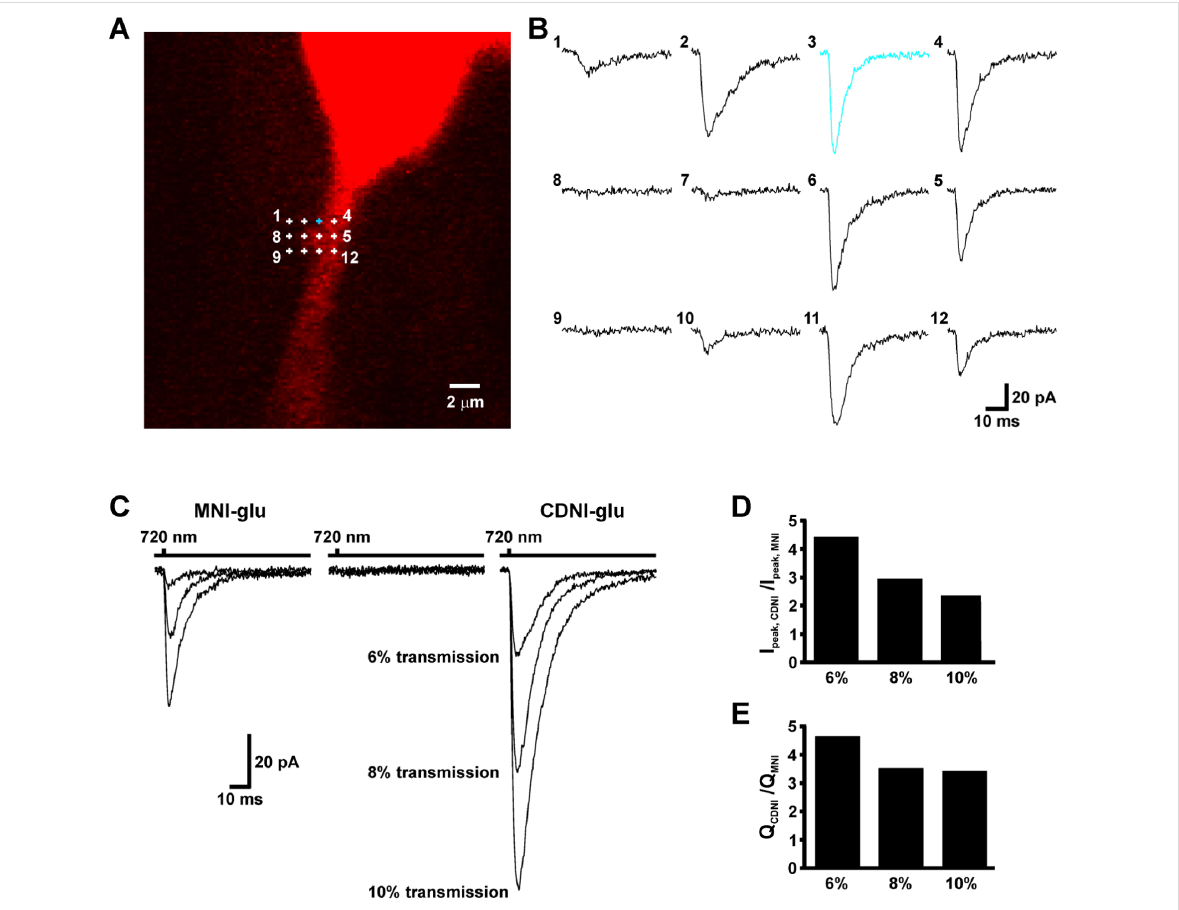
Figure 2: Comparative two-photon uncaging of MNI-Glu and CDNI-Glu on pyramidal neurons in an acutely isolated brain slice. (A) Fluorescent image of a pyramidal neuron filled with red dye. Numbered crosses correspond to the positions of the points of uncaging in B. (B) Currents evoked by two- photon irradiation at points marked in A. (C) Comparative photolysis of MNI-Glu and CDNI-Glu on the same neuron. The caged compound was topi- cally applied from a puffer pipette at a concentration of 10 mM above the brain slice. Current traces are an average of several trials. (D, E) Relative peak currents and charges evoked by CDNI/MNI. Note some receptor saturation from uncaging the more photoactive CDNI decreases the ratio at higher powers. Data courtesy of Martin Paukert and Dwight Bergles (Johns Hopkins School of Medicine). The two caged compounds were applied "blind" during these